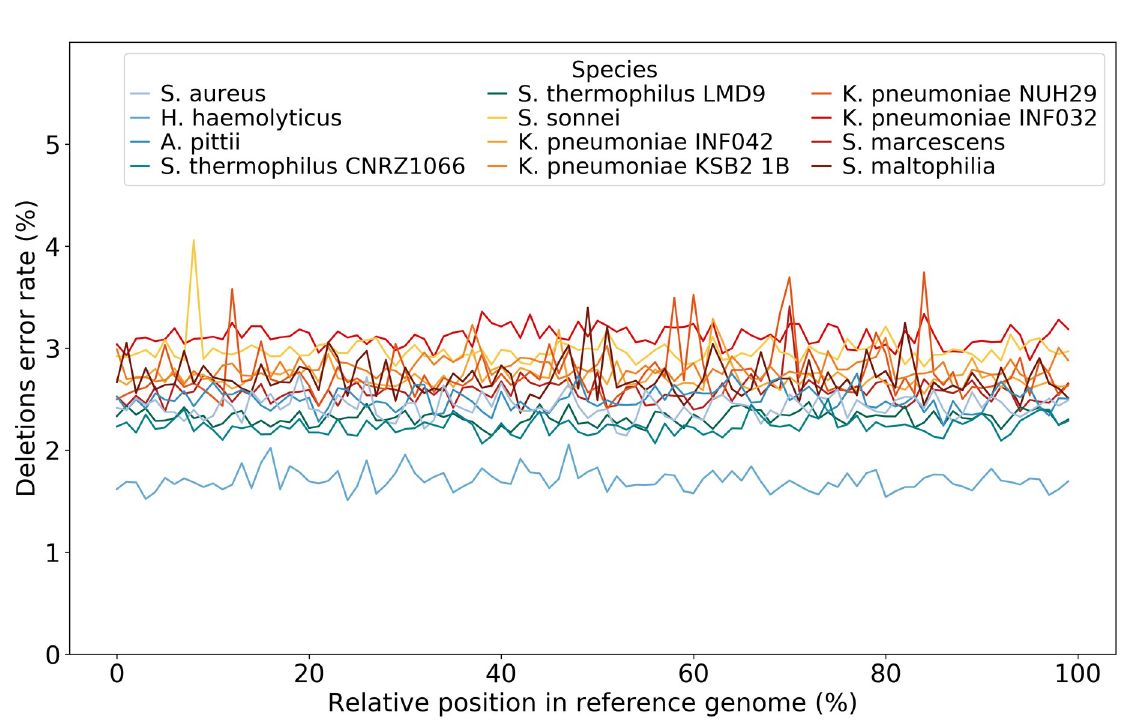
Fig 1. Mean deletion error rates on bacterial genomes basecalled with HAC mode. Species are sorted on their GC content, from blue (low) to red (high).